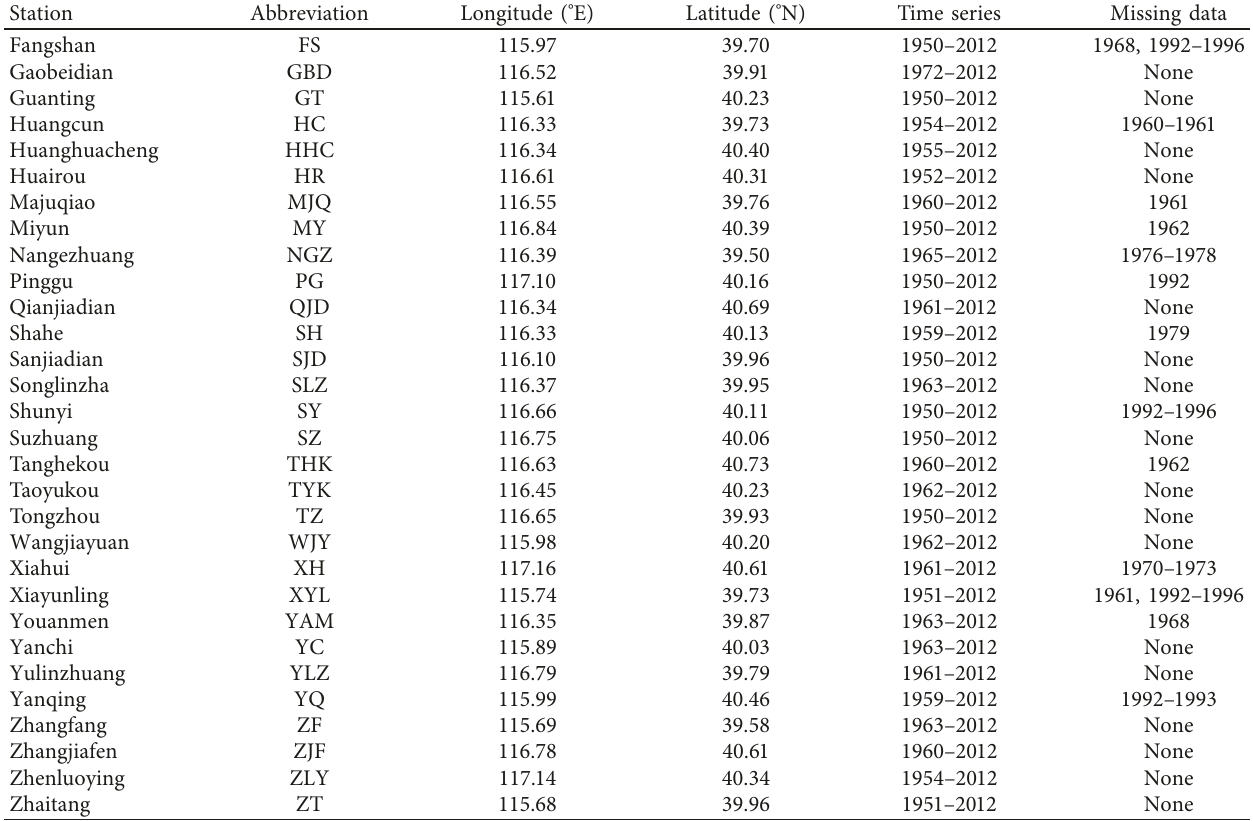
Table 1: Location of the 30 rain gauges and time series information.